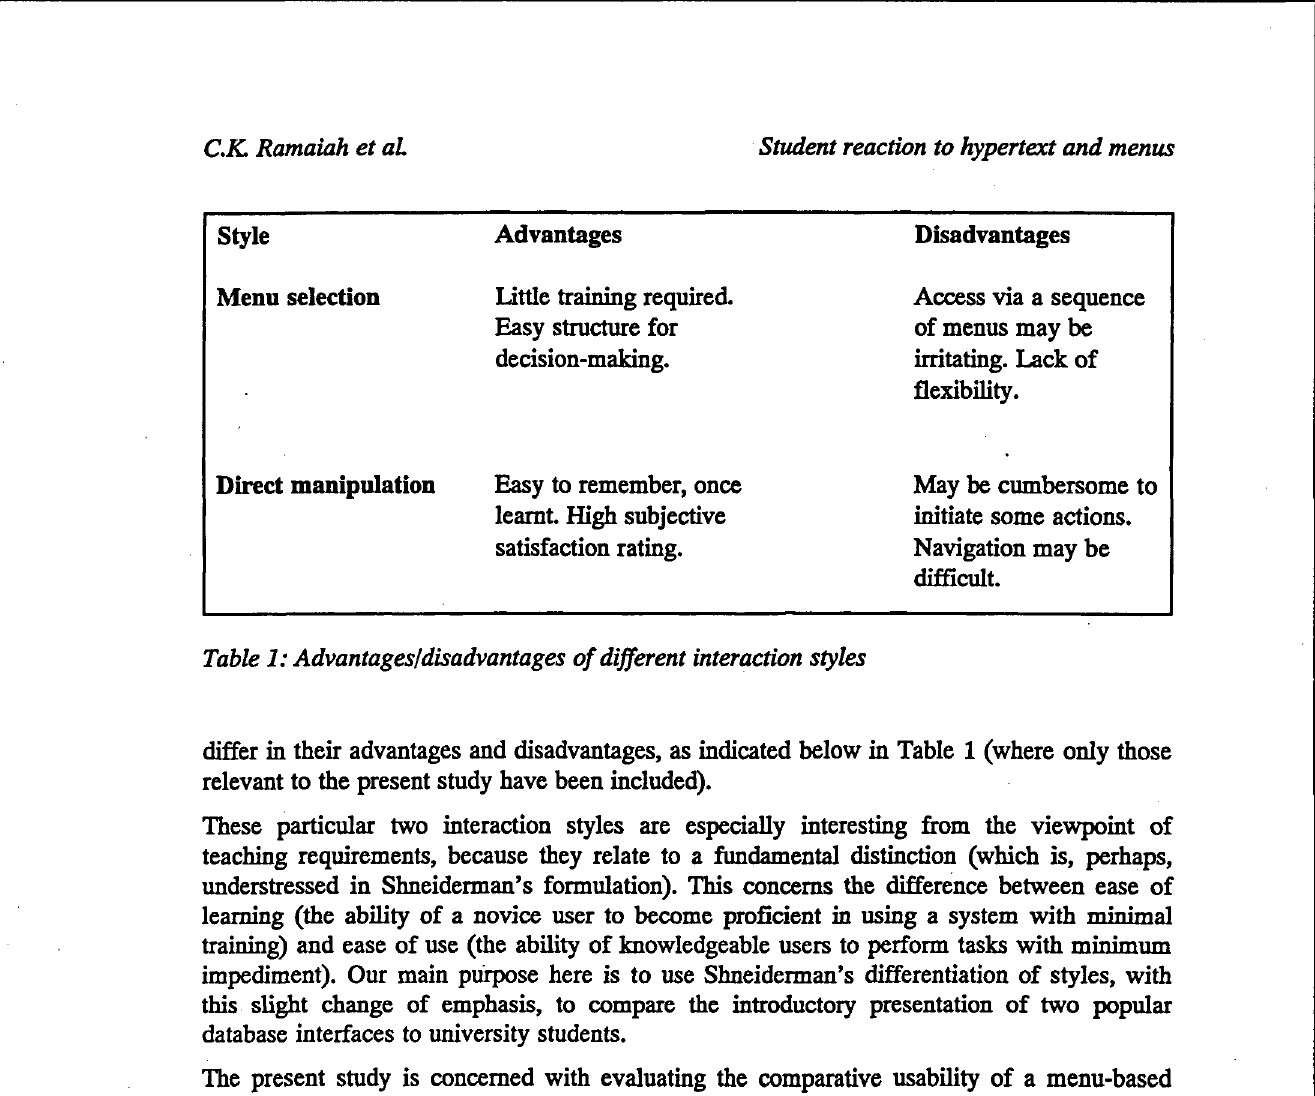
Table 1: Advantages/disadvantages of different interaction